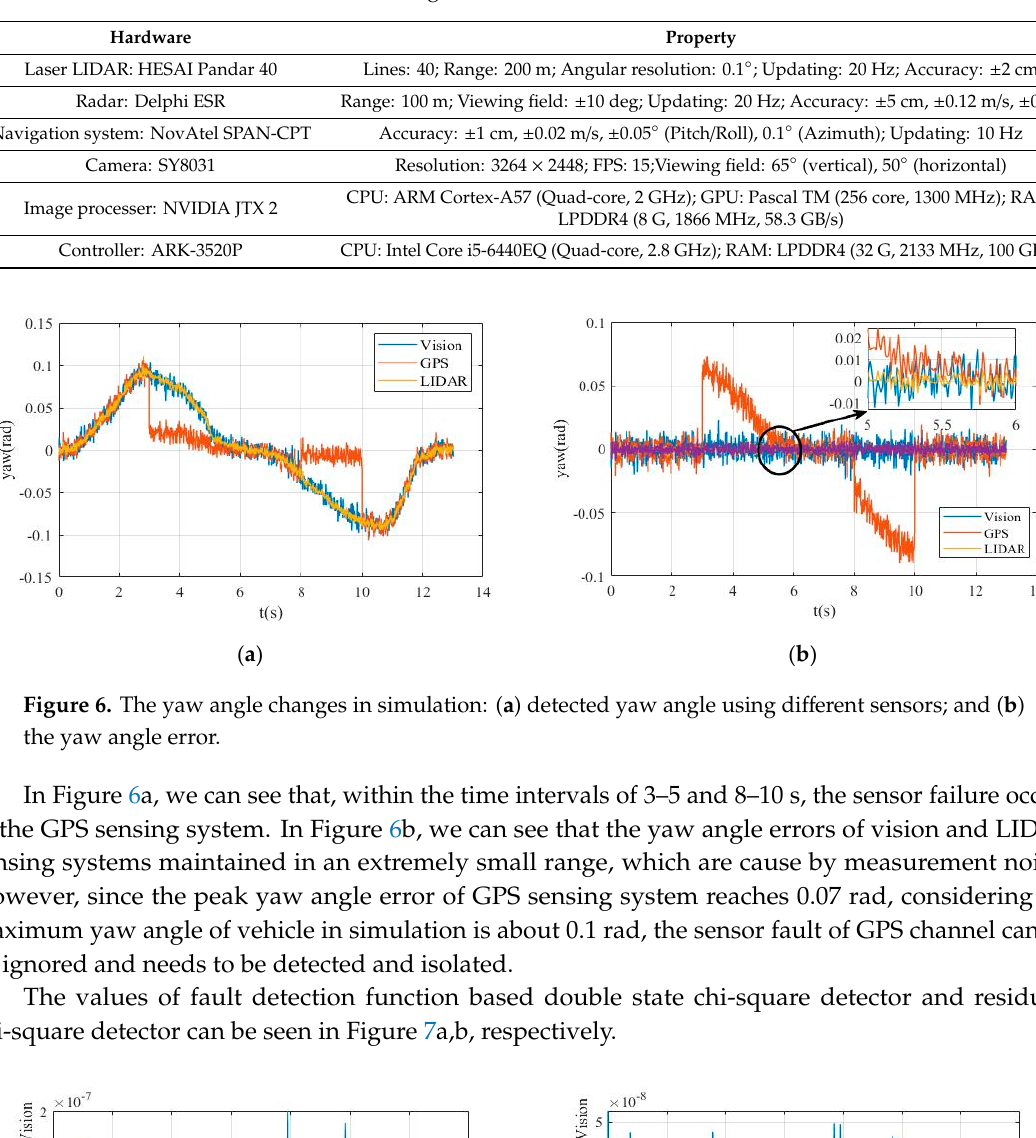
Table 1. Configurations of autonomous vehicle.